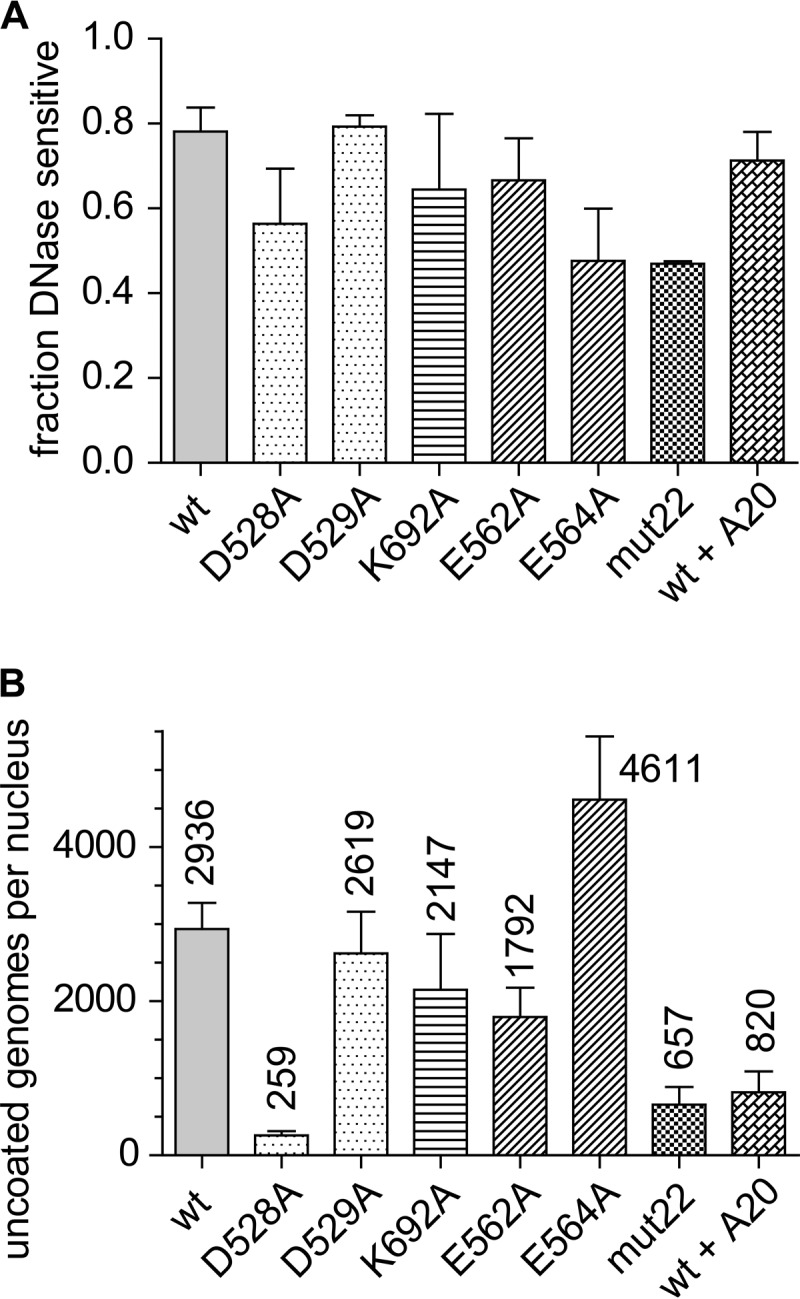
DNA uncoating in the nucleus. (A) Fractions of genomes in the nucleus that were DNase sensitive at 24 h and therefore considered uncoated. One-way ANOVA showed no significant difference in the rates of DNA uncoating once the mutants were in the nucleus. Error bars show standard errors of data from three separate experiments. (B) Numbers of wt or mutant genomes that were DNase sensitive per nucleus regardless of differences in cell entry or nuclear accumulation at 24 h postinfection. The numbers above each bar represent the means of results from three independent experiments; error bars show standard errors.